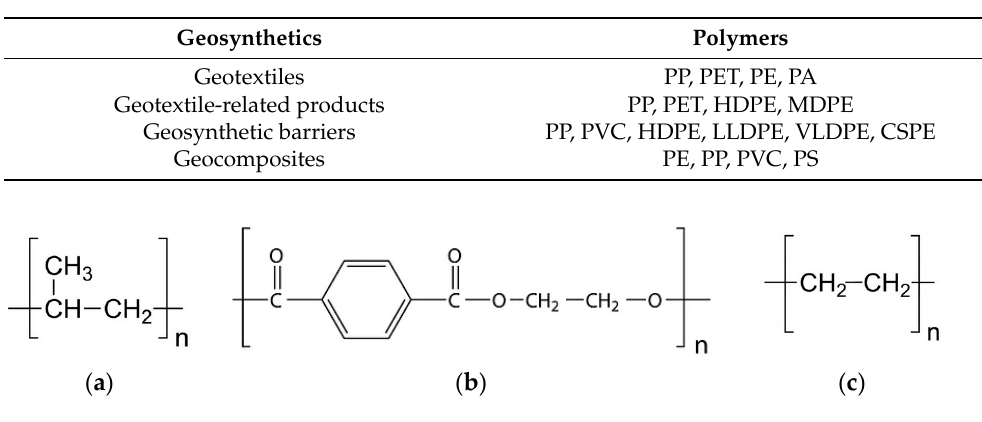
Table 1. Polymers used for geosynthetics manufacturing.